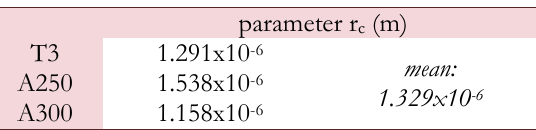
Table 3: Average value of r c length.